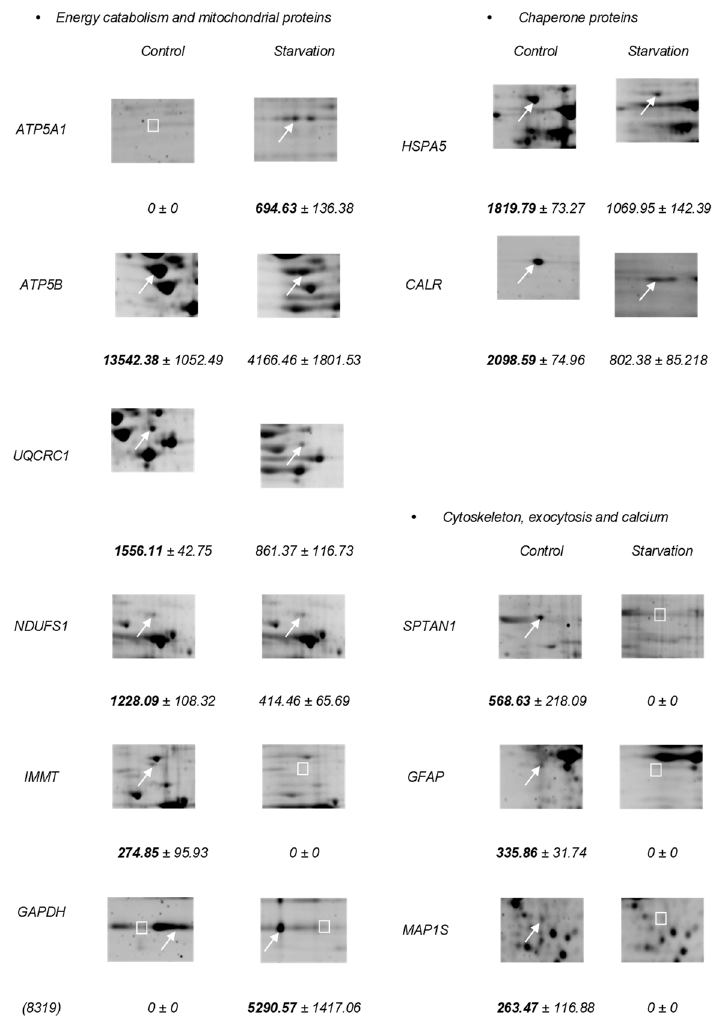
Figure 2. Enlarged images of 2-D gels that show the differential expression of 14 proteins identified in the rat brain. The arrows point to the spots and the squares indicate the absence of spots. Numbers in bold indicate that this spot is present in greater quantity than the other condition.